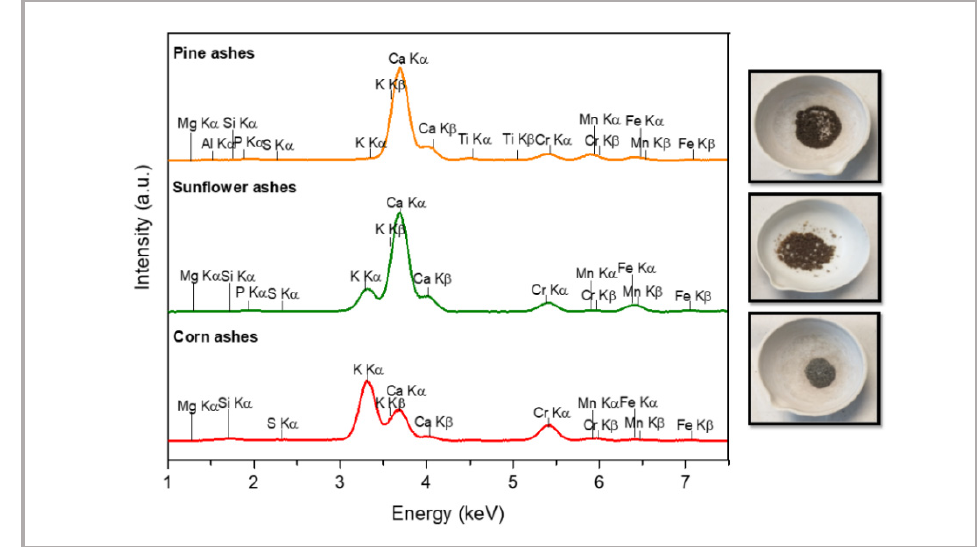
Figure 7. XRF of pine ashes, sunflower ashes and corn